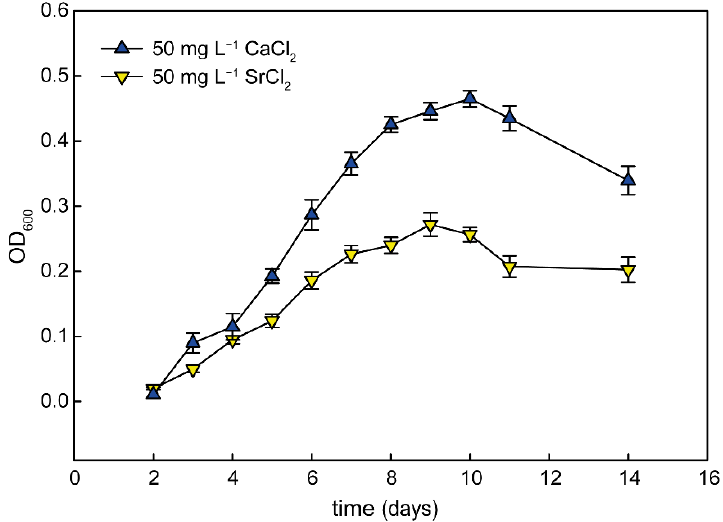
Figure 4. Growth rate of G. phototrophica grown in liquid media with 50 mg L −1 CaCl 2 and 50 mg L −1 SrCl 2 .